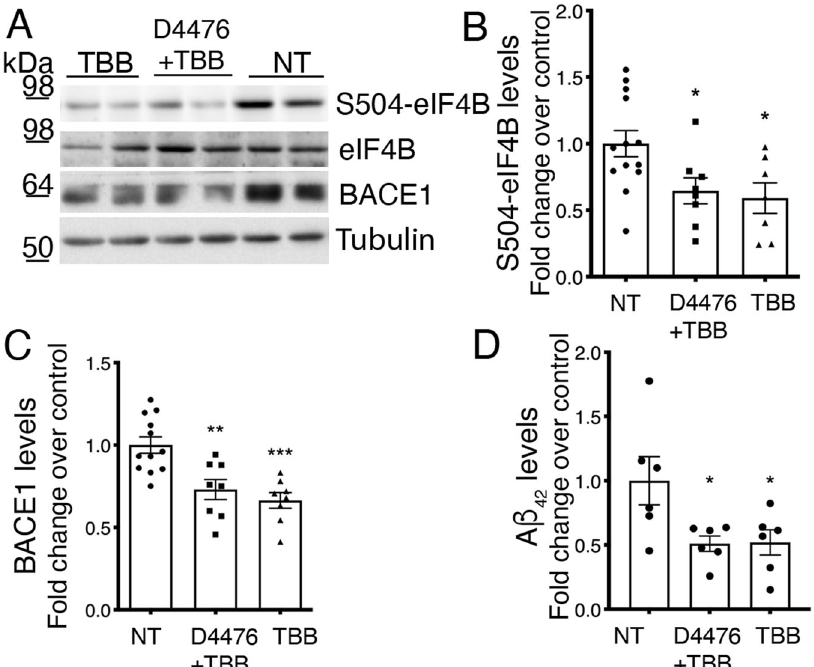
Fig. 5 Casein Kinase inhibition lowers BACE1 levels in organotypic slices from APPPS1 mice. A – C Western blot analysis for eIF4B total or phosphorylated (S504), BACE1, and Tubulin performed on extracts from APPPS1 brain slices treated with CK2 inhibitor (TBB), alone or in combination with CK1 inhibitor (D4476 + TBB) or left untreated (NT). Protein levels are shown as fold change over control (untreated slices). Levels of phosphorylated proteins are normalized against the corresponding total protein, then for loading (Tubulin) and shown as